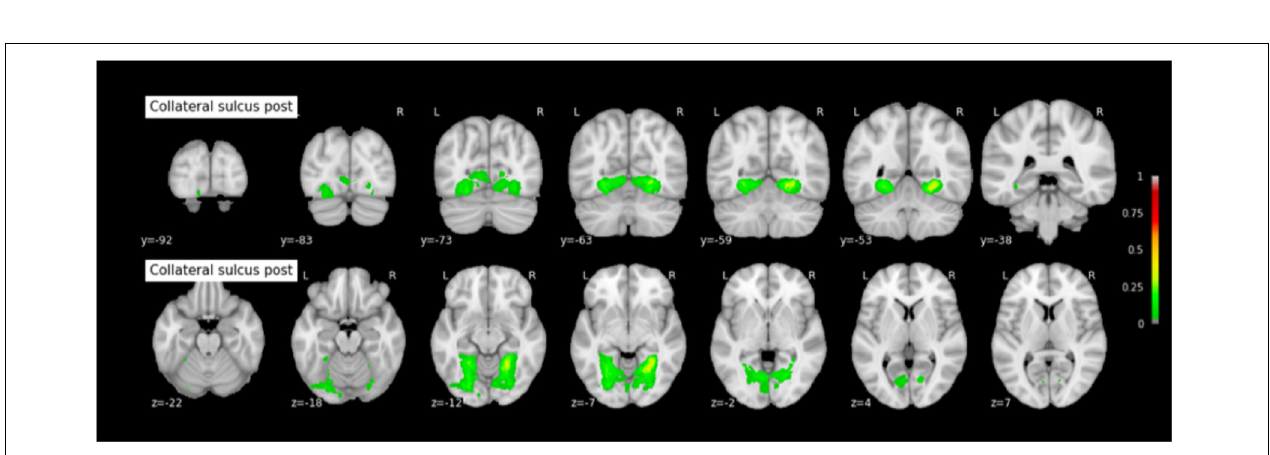
Frontiers in Neuroanatomy | www.frontiersin.org